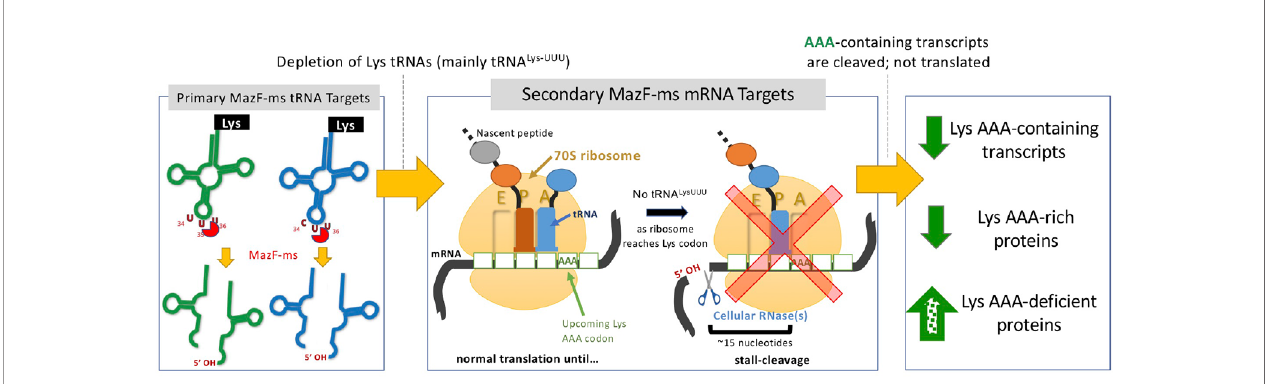
FIGURE 8 | Summary of the proposed MazF-ms mechanism of action. MazF-ms primarily targets tRNA Lys-UUU and tRNA Lys-CUU , depleting their intracellular levels. Inactivation of these tRNAs lead to selective ribosome stalling predominantly in rare Lys-AAA codons, culminating in cleavage of the transcript. This results in codon- biased proteomic changes, favoring Lys-AAA-depleted